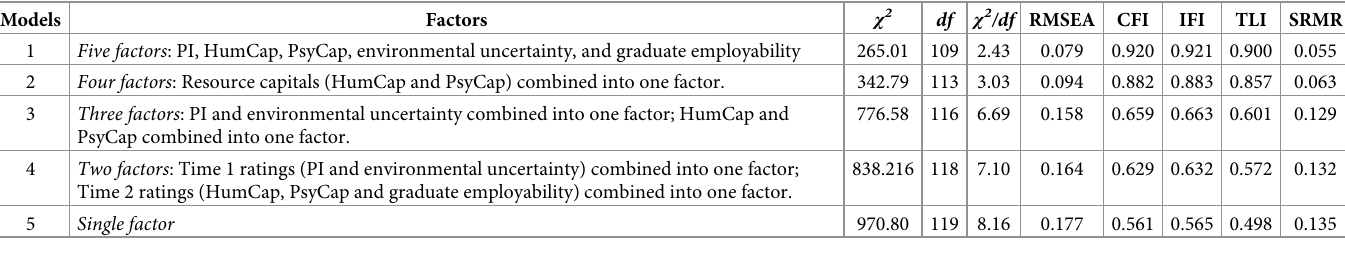
Table 1. Comparison of measurement